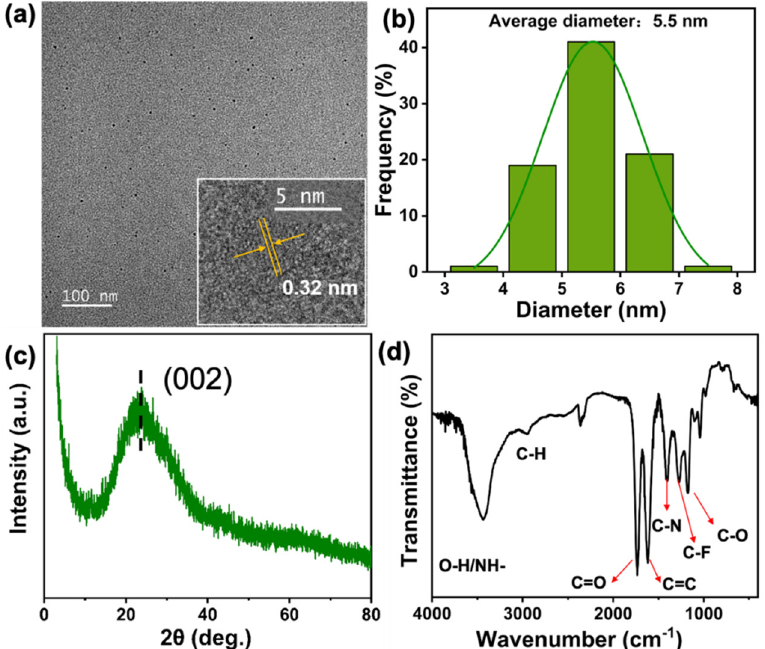
Figure 1. The structure characterization of NFCDs: ( a ) The well-dispersant quasi-spherical NFCDs particles were seen in high-resolution transmission electron microscope (HR-TEM) images. Inset: the lattice space of 0.32 nm. ( b ) The average diameter of NFCDs, determined by Gaussian fitting. ( c ) The 002 peak in XRD confirms the graphitic nature of the NFCD seen in the HR-TEM image ( a ). ( d ) The FT-IR spectrum of NFCDs presented the stretching vibrations of the surface functional groups.